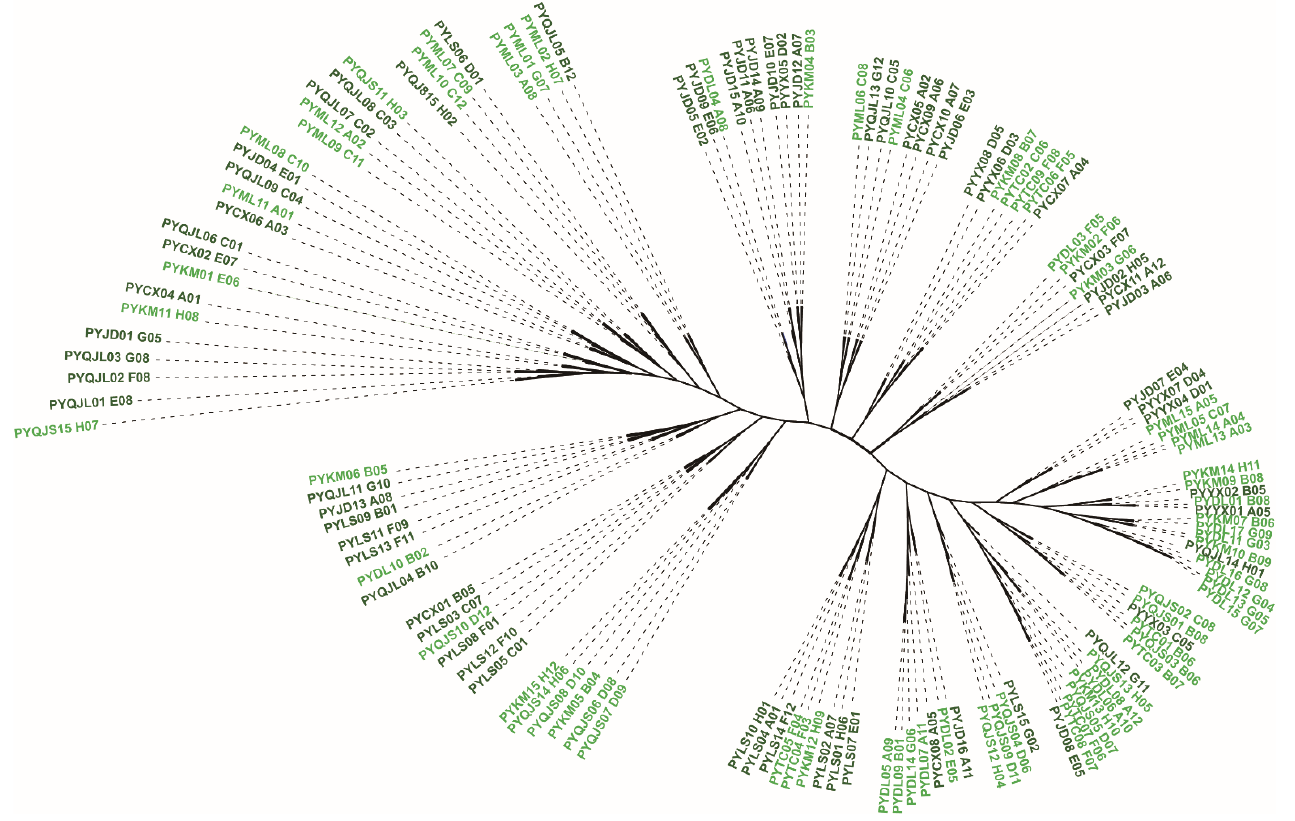
Figure 5. Genetic divergence of 136 individuals based on UPGMA cluster analysis. The long-stalked variety and the short-stalked variety are denoted with dark green and light green.